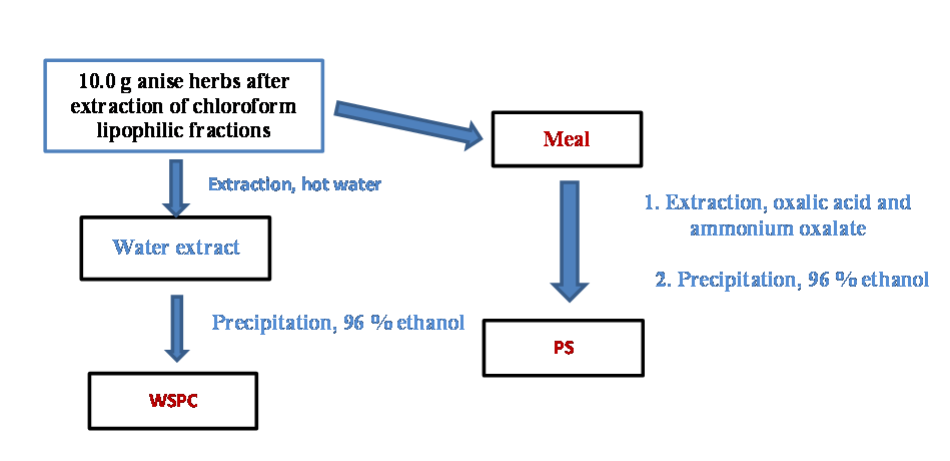
Fig. 1. The algorithm for obtaining WSPC and